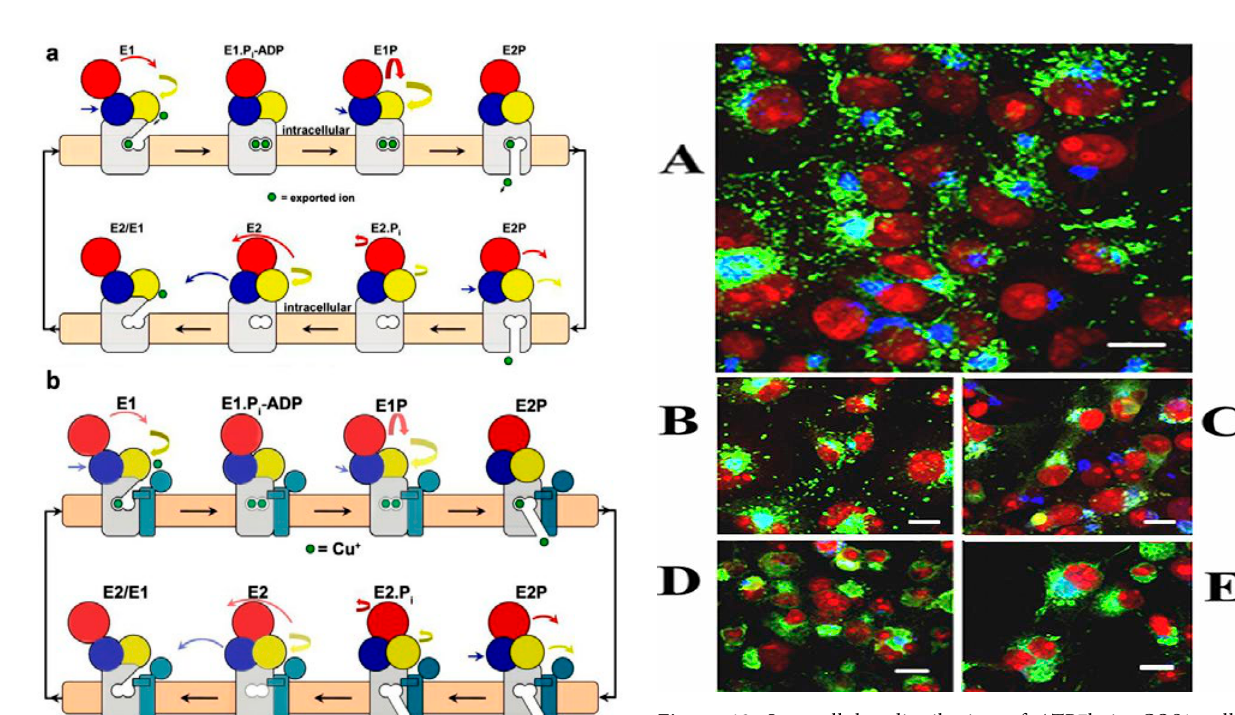
Figure 12. Intracellular distribution of ATP7b in COS1 cells expressing WT enzyme (A), subjected to mutation at Asp-1027 (B), Ser-478, Ser-481, Ser-1121 and SER-1453 (C), at the transmem- brane (TMBD) copper site (D), or at the sixth NMBD copper site (E). Note the presence of cytosolic trafficking vesicles with WT enzyme (A), and even and even following Asp-1027 mutation (B), but no trafficking following serine, NMBD or TMBD copper sites (C, D and E). 25,